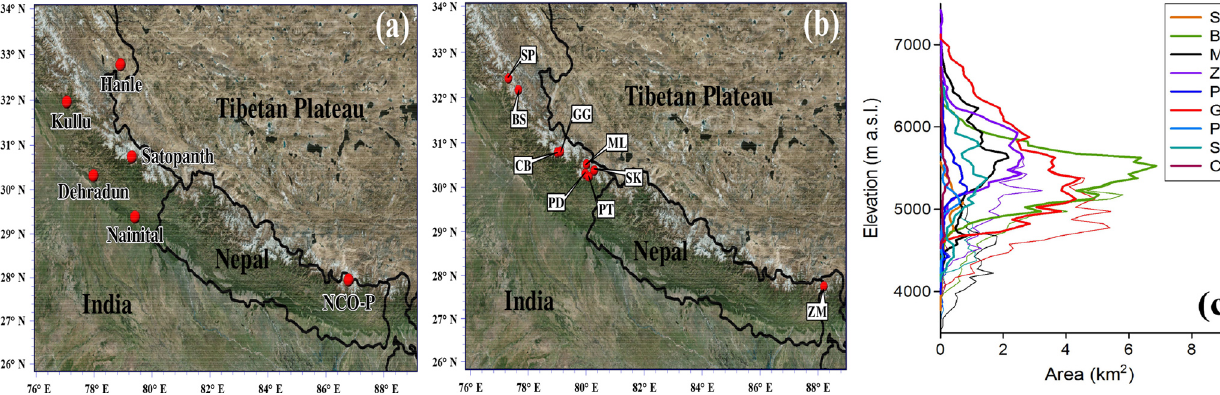
Figure 1. Map of the study domain showing (a) six stations of available measurements and (b) simulated glaciers as well as (c) hypsometry of nine glaciers. Outline of glaciers are based on GAMDAM glacier inventory (Nuimura et al., 2015). Thick and thin lines denote debris-free and debris-covered areas, respectively. The debris-covered area was excluded from the calculation. Glacier abbreviations and details are listed in Table 1. Table 1. Description of glaciers considered in this